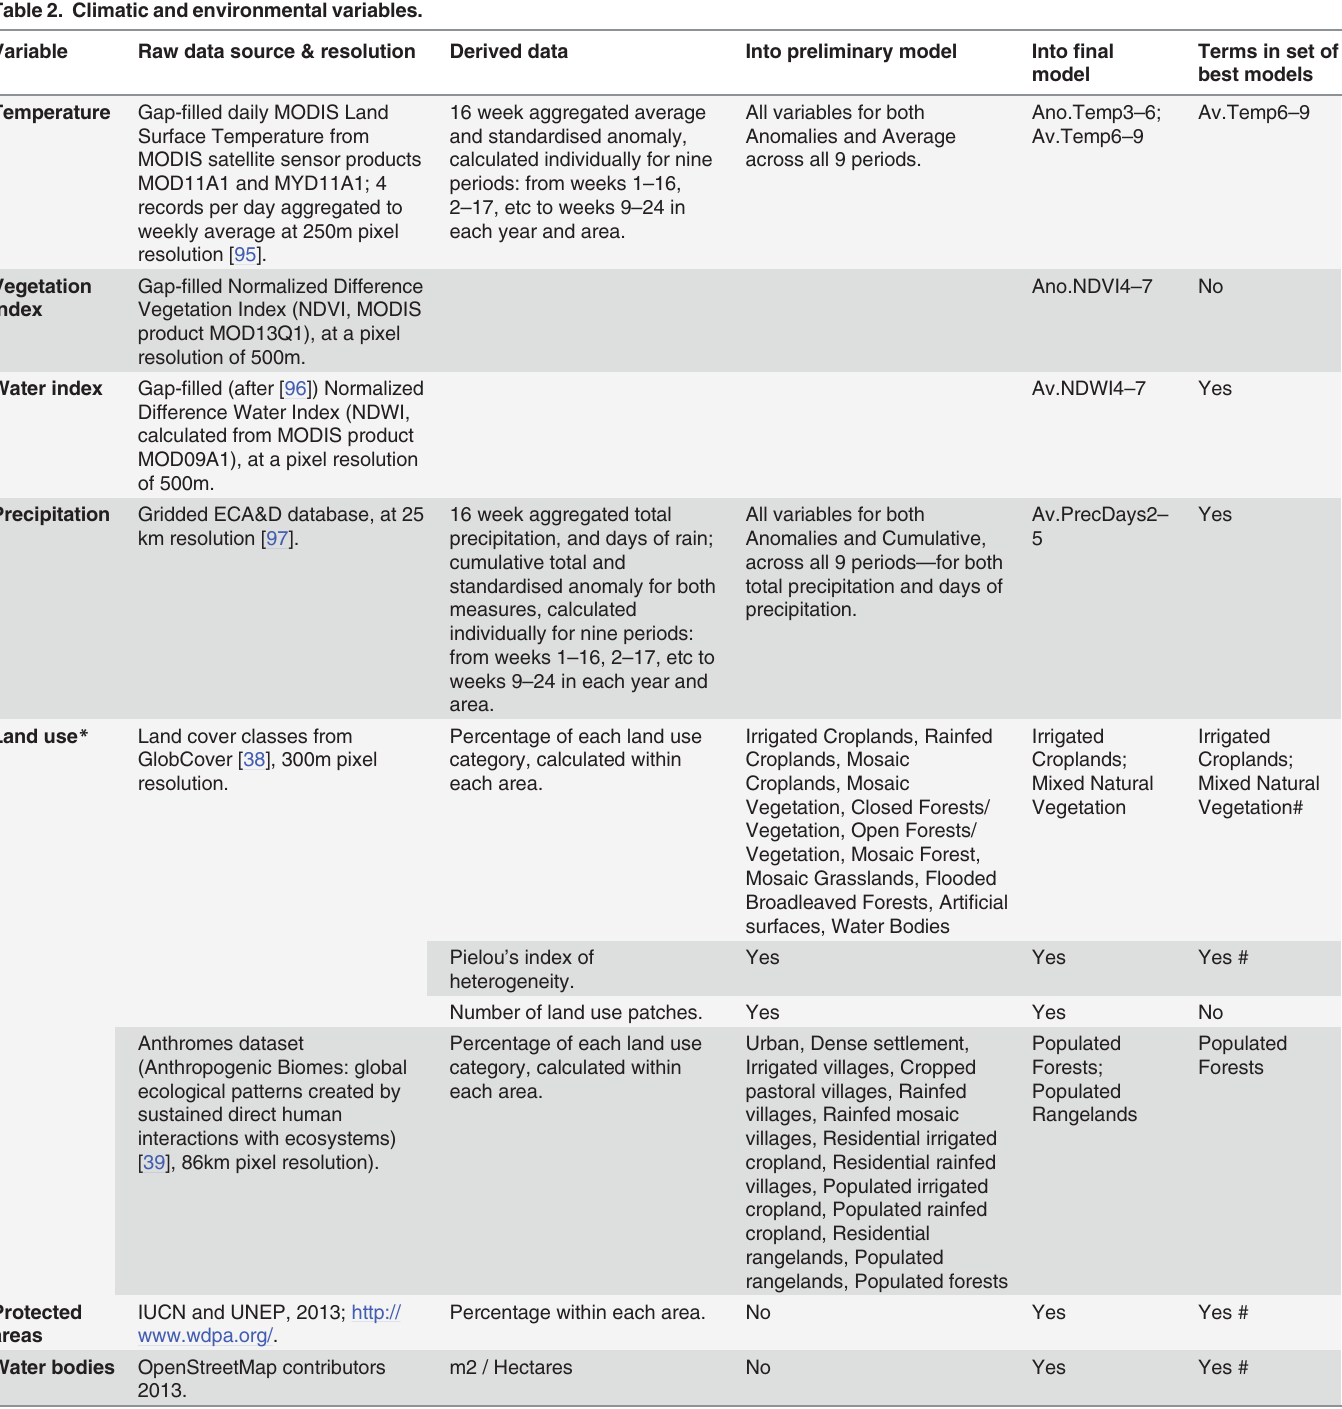
Table 2. Climatic and environmental